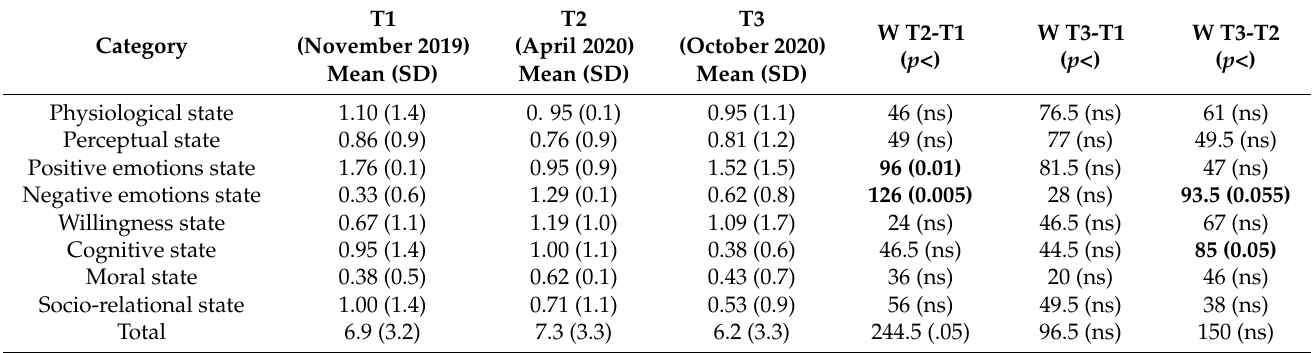
Table 2. Means and standard deviations of the psychological lexicon measured in the SSG at the three observation times and the results of the analysis with Wilcoxon’s W-statistic.